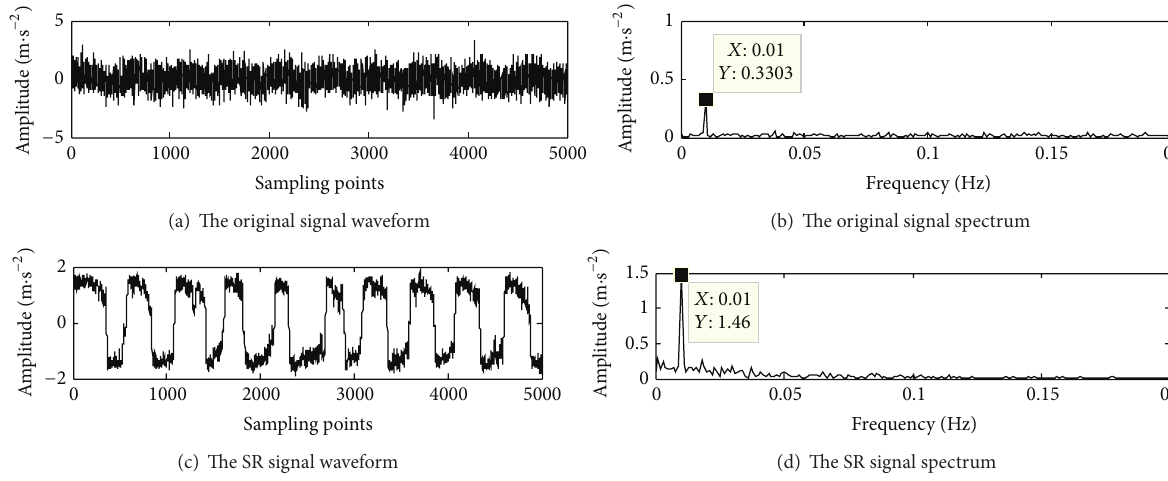
Figure 4: The time-domain waveform and frequency spectrum of original signal and stochastic resonance signal.